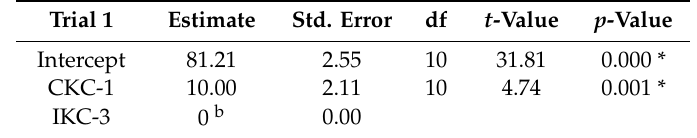
Table 9. The significant di ff erence of mean scores obtained in Trial 2 between CKC-1 and IKC-3. Trial 2 Estimate Std. Error df t -Value p -Value Intercept 84.85 2.03 10 41.83 0.000 * CKC-1 7.27 1.84 10 3.94 0.003 * IKC-3 0 b 0.00